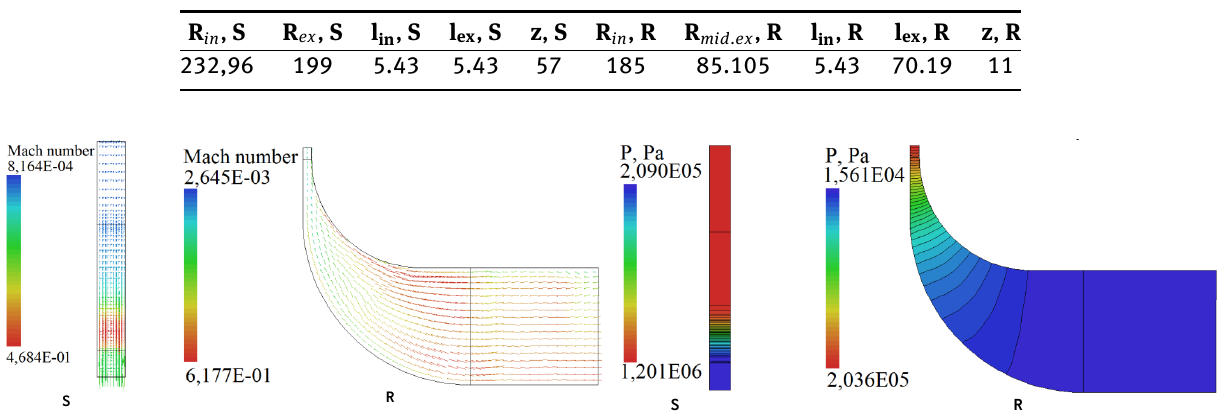
Figure 18. Static pressure contours in a meridional section at the mid blade-to-blade section